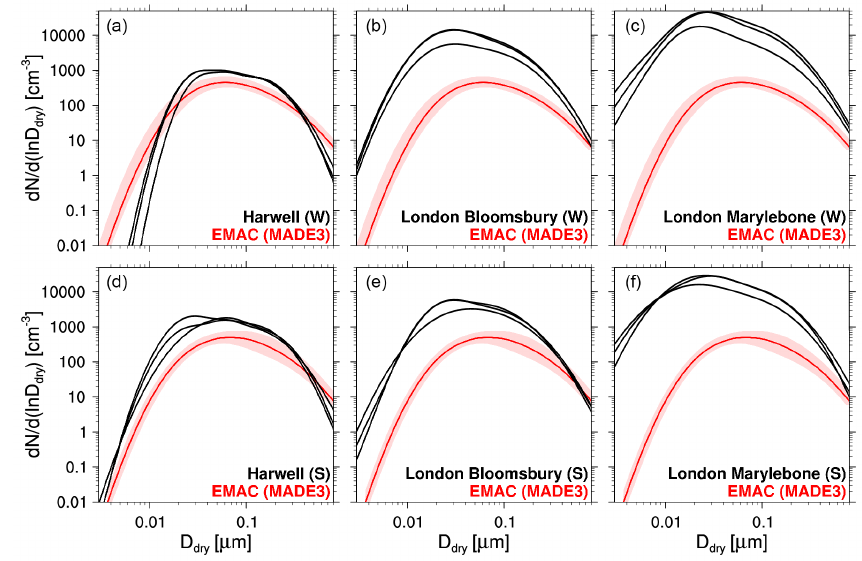
Figure 7. Aerosol particle number size distributions in the EMAC simulation with MADE3 (red) vs. ground-based measurements (Putaud et al., 2003; Van Dingenen et al., 2004) during winter (W, a–c ) and summer (S, d–f ) at the same locations (columns). Each plot contains three measured size distributions: one for the morning, one for the afternoon, and one for the night hours. The three stations represent the following conditions (left to right): rural, urban, and kerb side (terminology adapted from Putaud et al., 2003). All measurement locations fall into the same model grid box, so that the simulated size distribution only differs between the top and bottom rows but not between columns. Solid lines stand for median values; shadings indicate the 25th to 75th percentiles. Note that the vertical axis of the left plot in each row applies to the other plots of that row as well, and the horizontal axes of the plots in the lowermost row also apply to the other plots in the respective